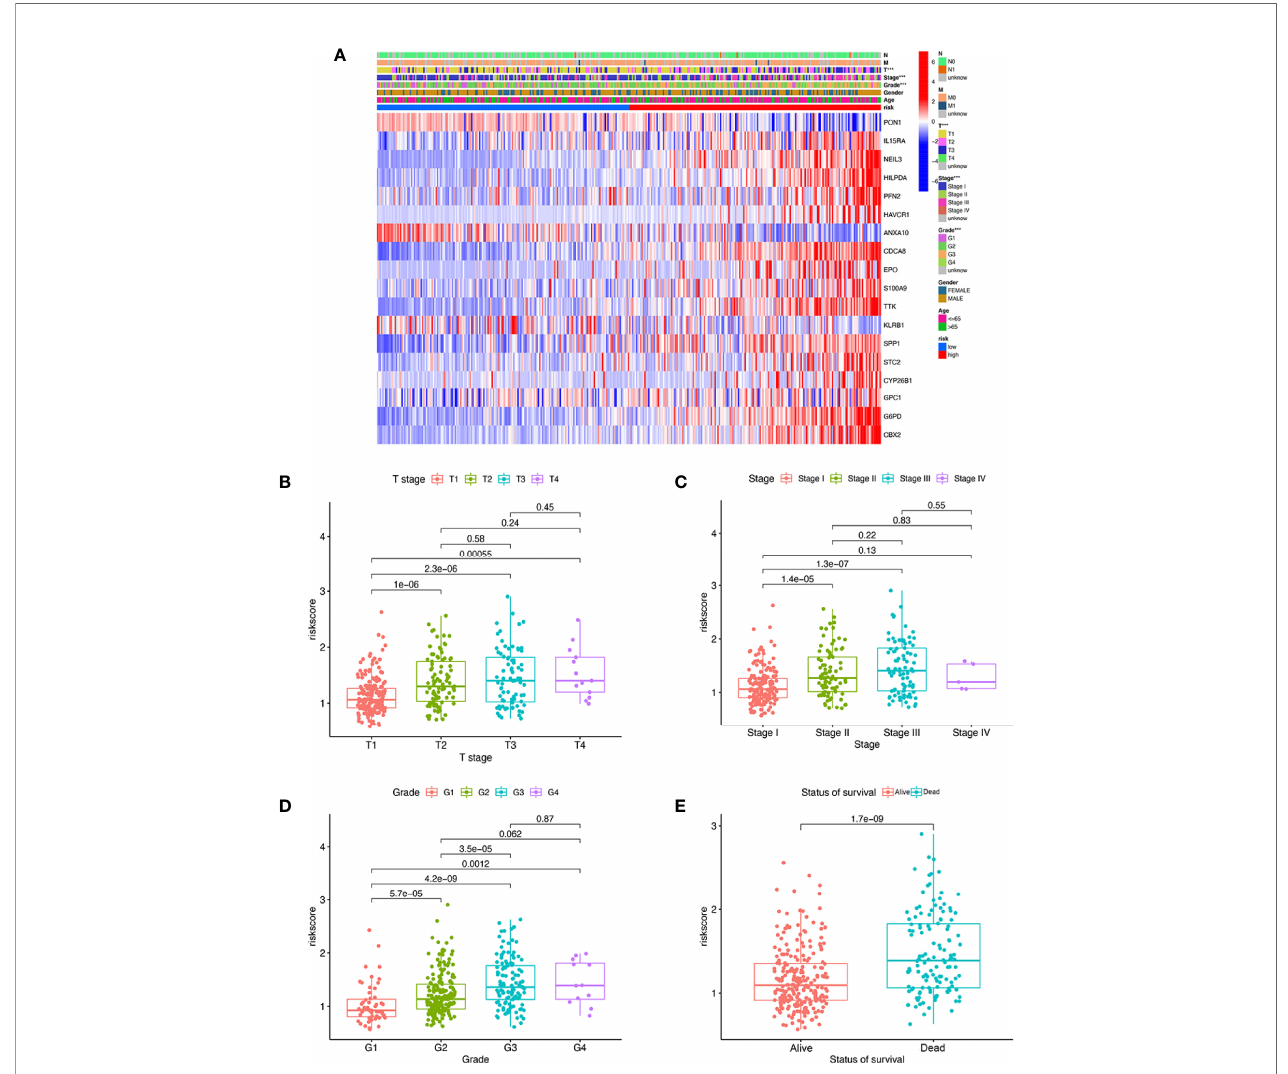
FIGURE 6 | The MRS signature based on macrophage-related clusters was associated with the clinicopathological characteristics of patients with HCC in the TCGA-LIHC dataset. (A) Heatmap for the MRS signature based on macrophage-related clusters and clinicopathological manifestation. (B) Boxplot of risk score based on macrophage-related clusters in HCC patients with different stages. (C) Boxplot of risk score based on macrophage-related clusters in HCC patients with different tumor stages. (D) Boxplot of risk score based on macrophage-related clusters in HCC patients with different pathological grades. (E) Boxplot of risk score based on macrophage-related clusters in HCC patients with different status of survival. *** P <